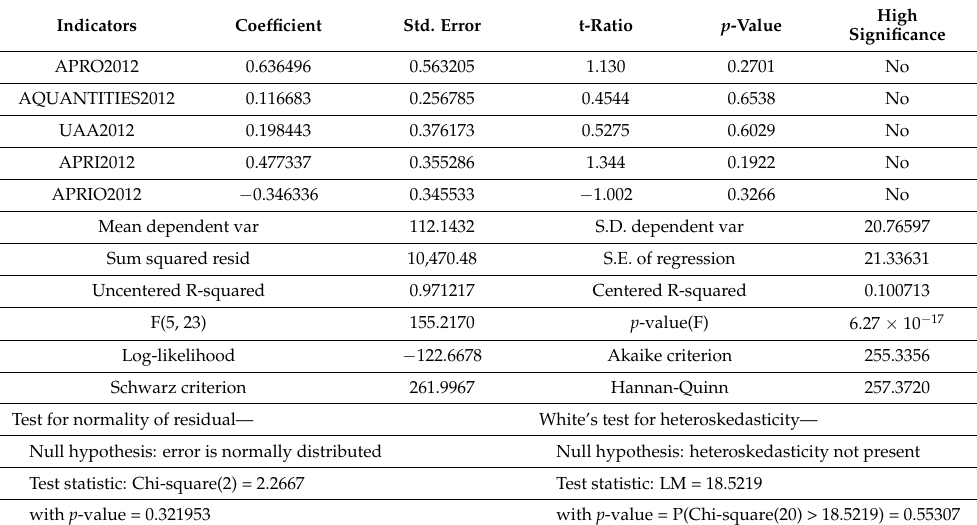
Table 2. Model 2012: OLS, using observations 1–28 (Dependent variable: